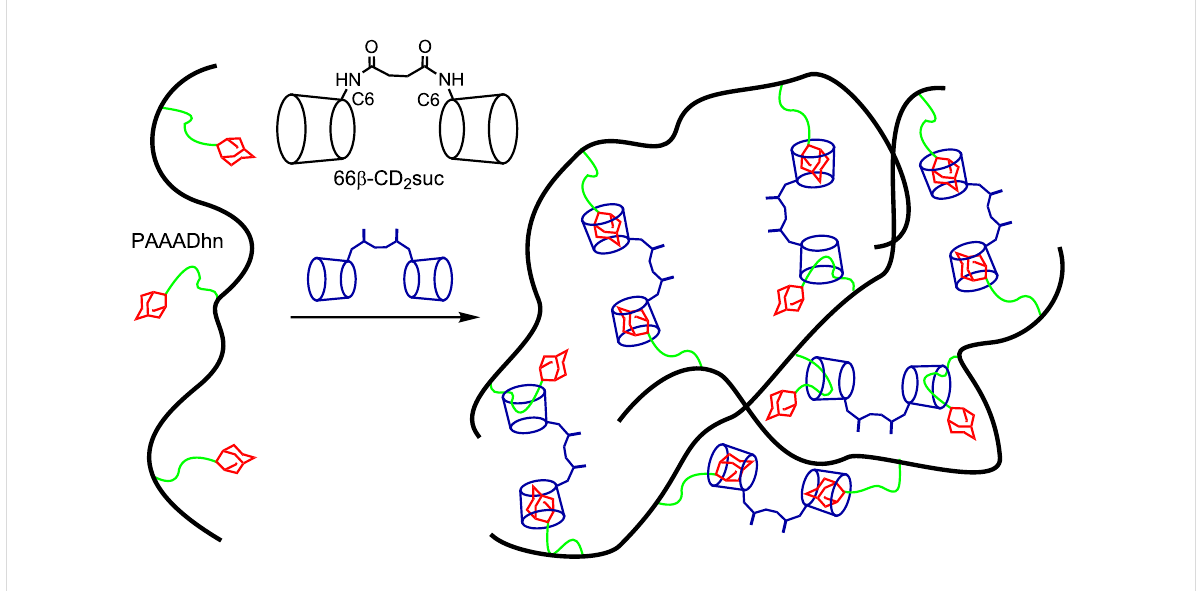
Figure 9: Competitive host–guest complexations in which either the adamantyl substituent (red) or the n -hexyl tether (green) of PAAADhn is the guest in the 66 β -CD 2 suc annuli to form a hydrogel network [76].